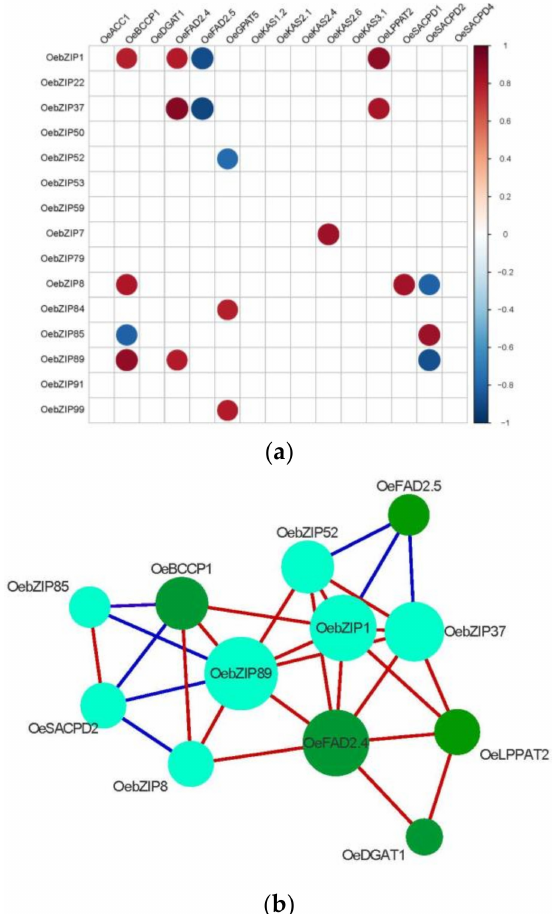
Figure 10. Correlation analysis of OebZIP with lipid synthesis genes ( a ) Red dot indicates a positive correlation; blue dot indicates a negative correlation, while the di ff erent colors represent the p -values of the correlation. ( b ) The predicted interaction network of OeLPGs and OebZIPs . Red lines are positive regulations, blue lines are